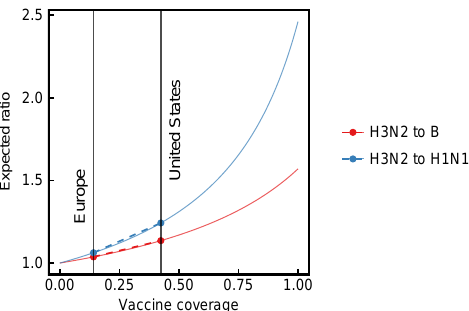
Figure 1. Expected change in the ratios of strains for increasing vaccine coverage. Here, we consider H3N2, H1N1, and B as separate strains. Points show expected subtype ratios at approximate vaccine coverages in the United States and Europe (vertical lines). Dashed lines indicate direct comparisons between expected subtype ratios in the United States and Europe. Here, we assume that subtypes occur at equal frequencies without vaccination, and that VE over multiple seasons is the mean of VEs measured in each season. VE estimates are based on TND studies in Canada